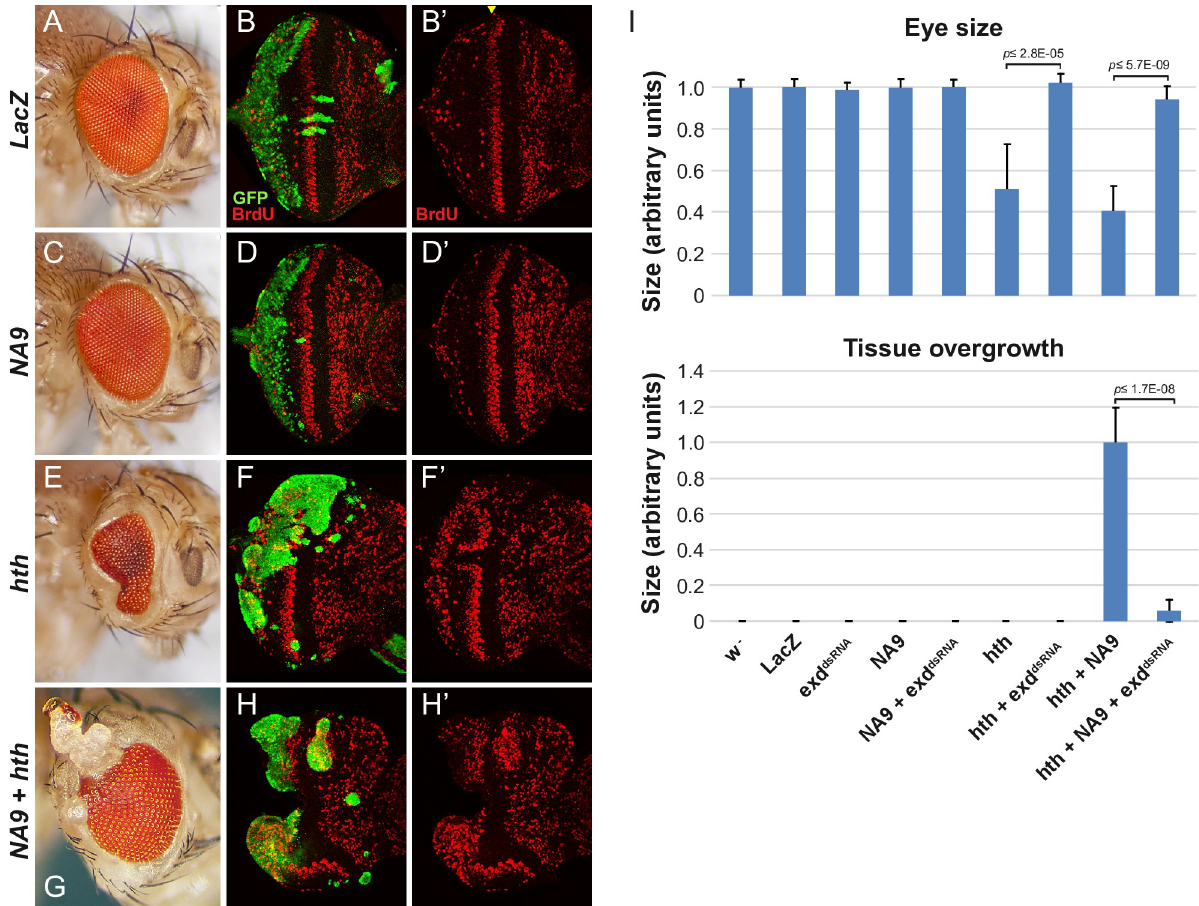
Fig 2. NUP98-HOXA9 collaborates with HTH during Drosophila eye development. FLP-out clones produced in the eye using ey-FLP; Act5C > CD8 > Gal4 , UAS-GFP were analyzed at the adult and larval stages. (A, C, E, G) Micrographs of representative adult Drosophila eyes clonally expressing (A) UAS-LacZ/+ , (B) UAS-NA9/+ , (C) UAS-GFP-hth , and (D) UAS-NA9/UAS-GFP-hth as indicated to the left of each panel. (B, D, F, H) Third instar eye discs labeled with BrdU revealing cells in S phase. GFP staining marks the positions of clones expressing the transgenes indicated to the left of the panels. Yellow arrowhead indicates the position of the second mitotic wave. (I) Quantification of eye size and tissue overgrowth. Statistical significance was assessed using a Student’s t